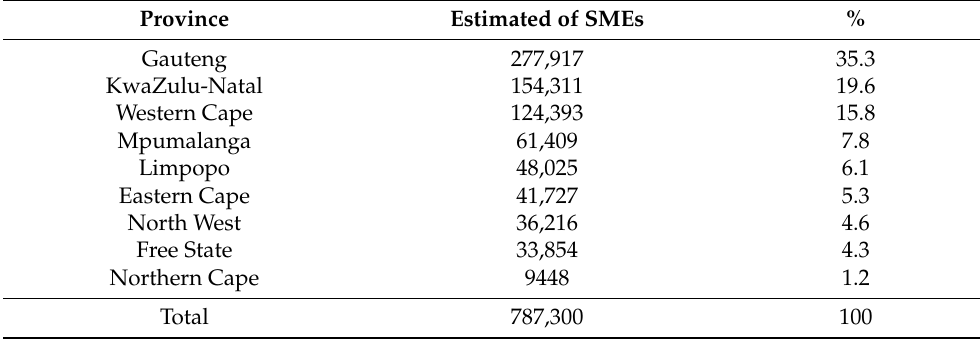
Table 1. Distribution of small and medium enterprises (SMEs) in the 9 South African